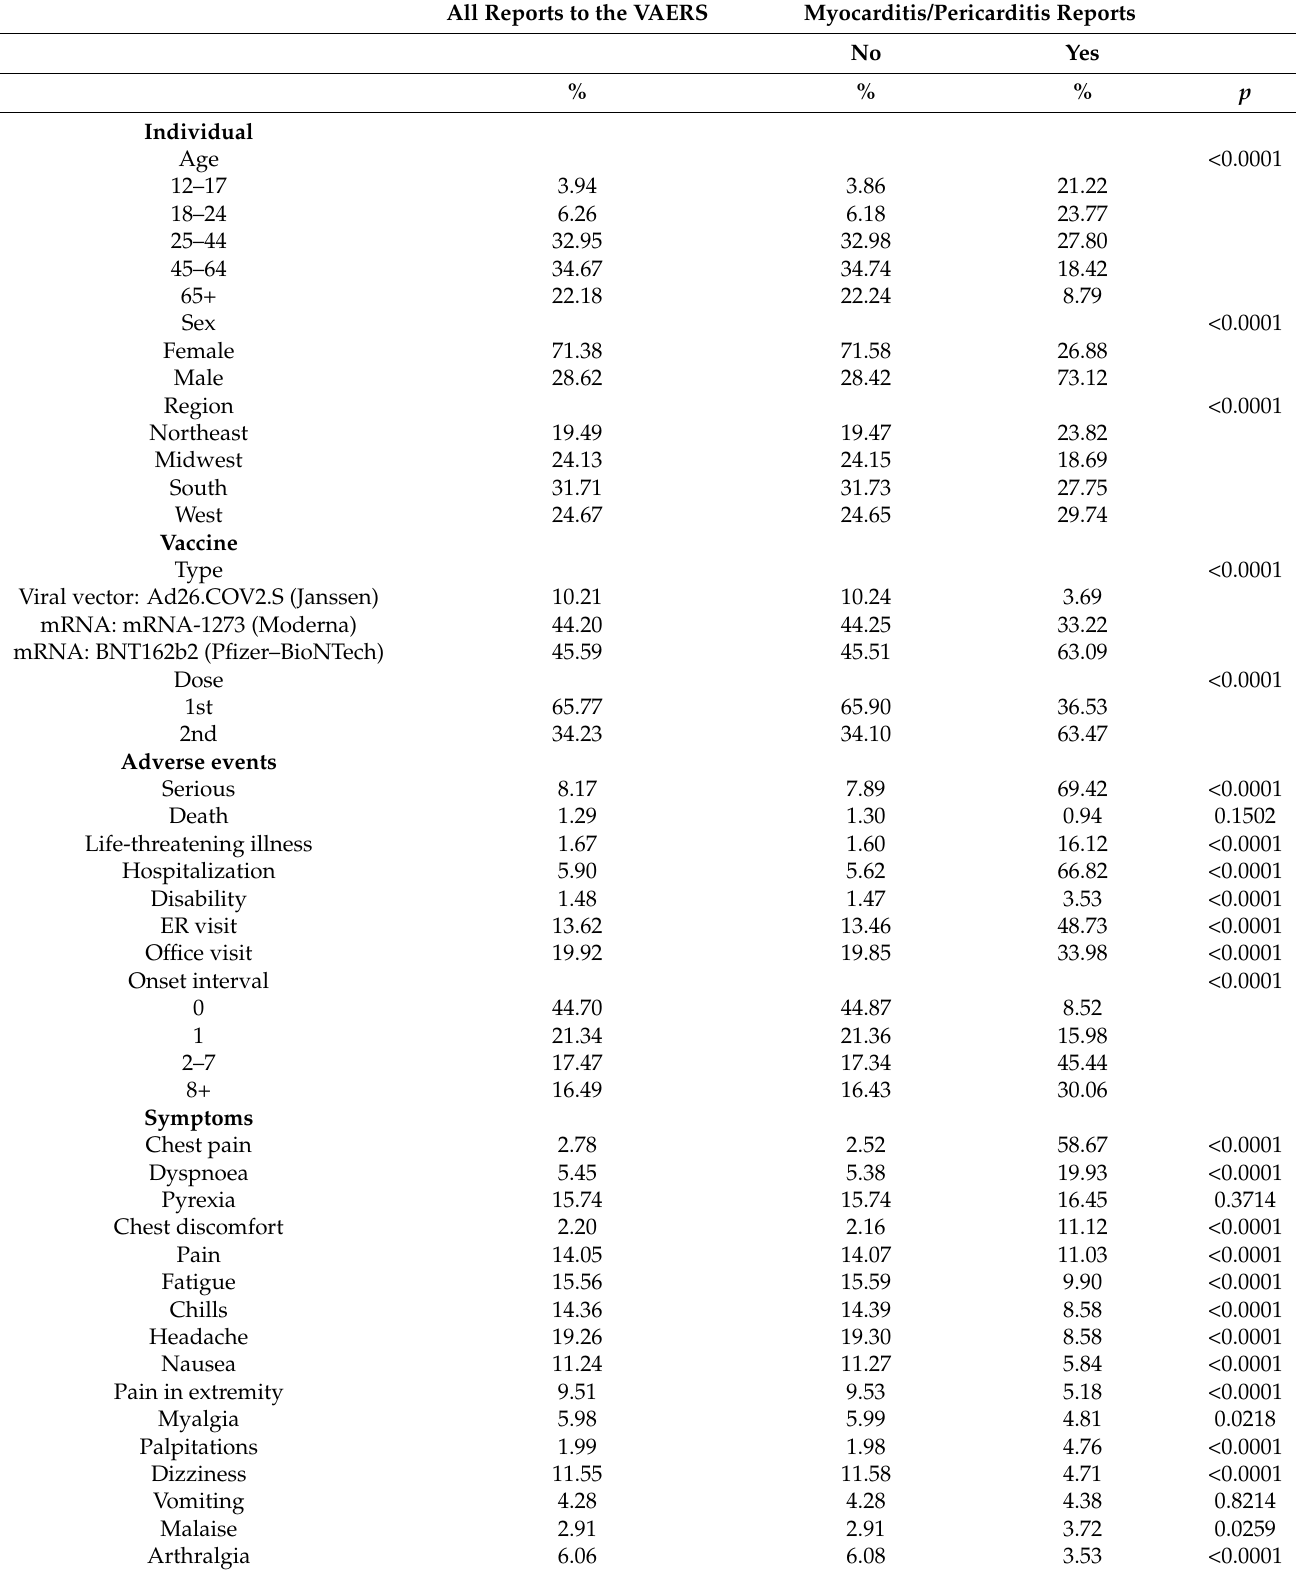
Table 1. Characteristics of reports to the VAERS following COVID-19 vaccination by